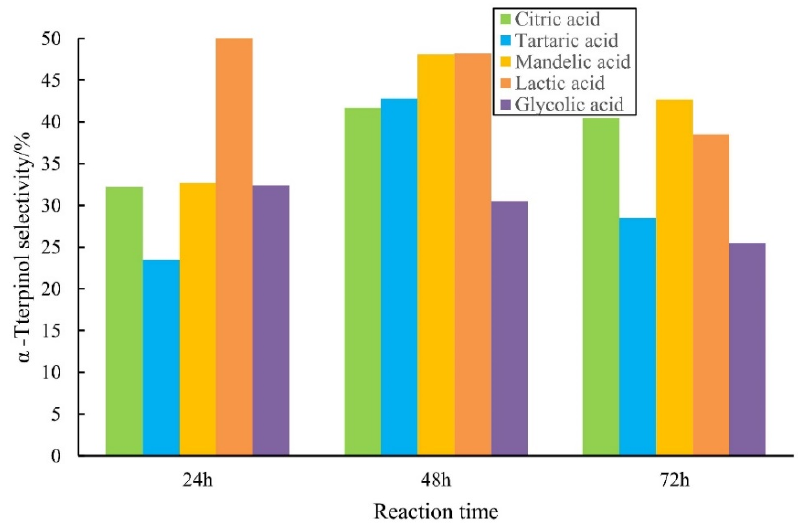
Figure 2. Selectivity comparison of alpha-terpinol with AHA as the catalyst. Note: The mass ratio of alpha-pinene, water and AHA was 1:1:1 at 70 °C.